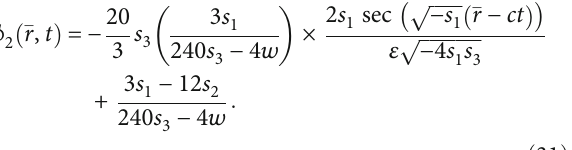
ð (cid:1) r , t Þ , for (cid:1) r , t = − π :: π , s 3